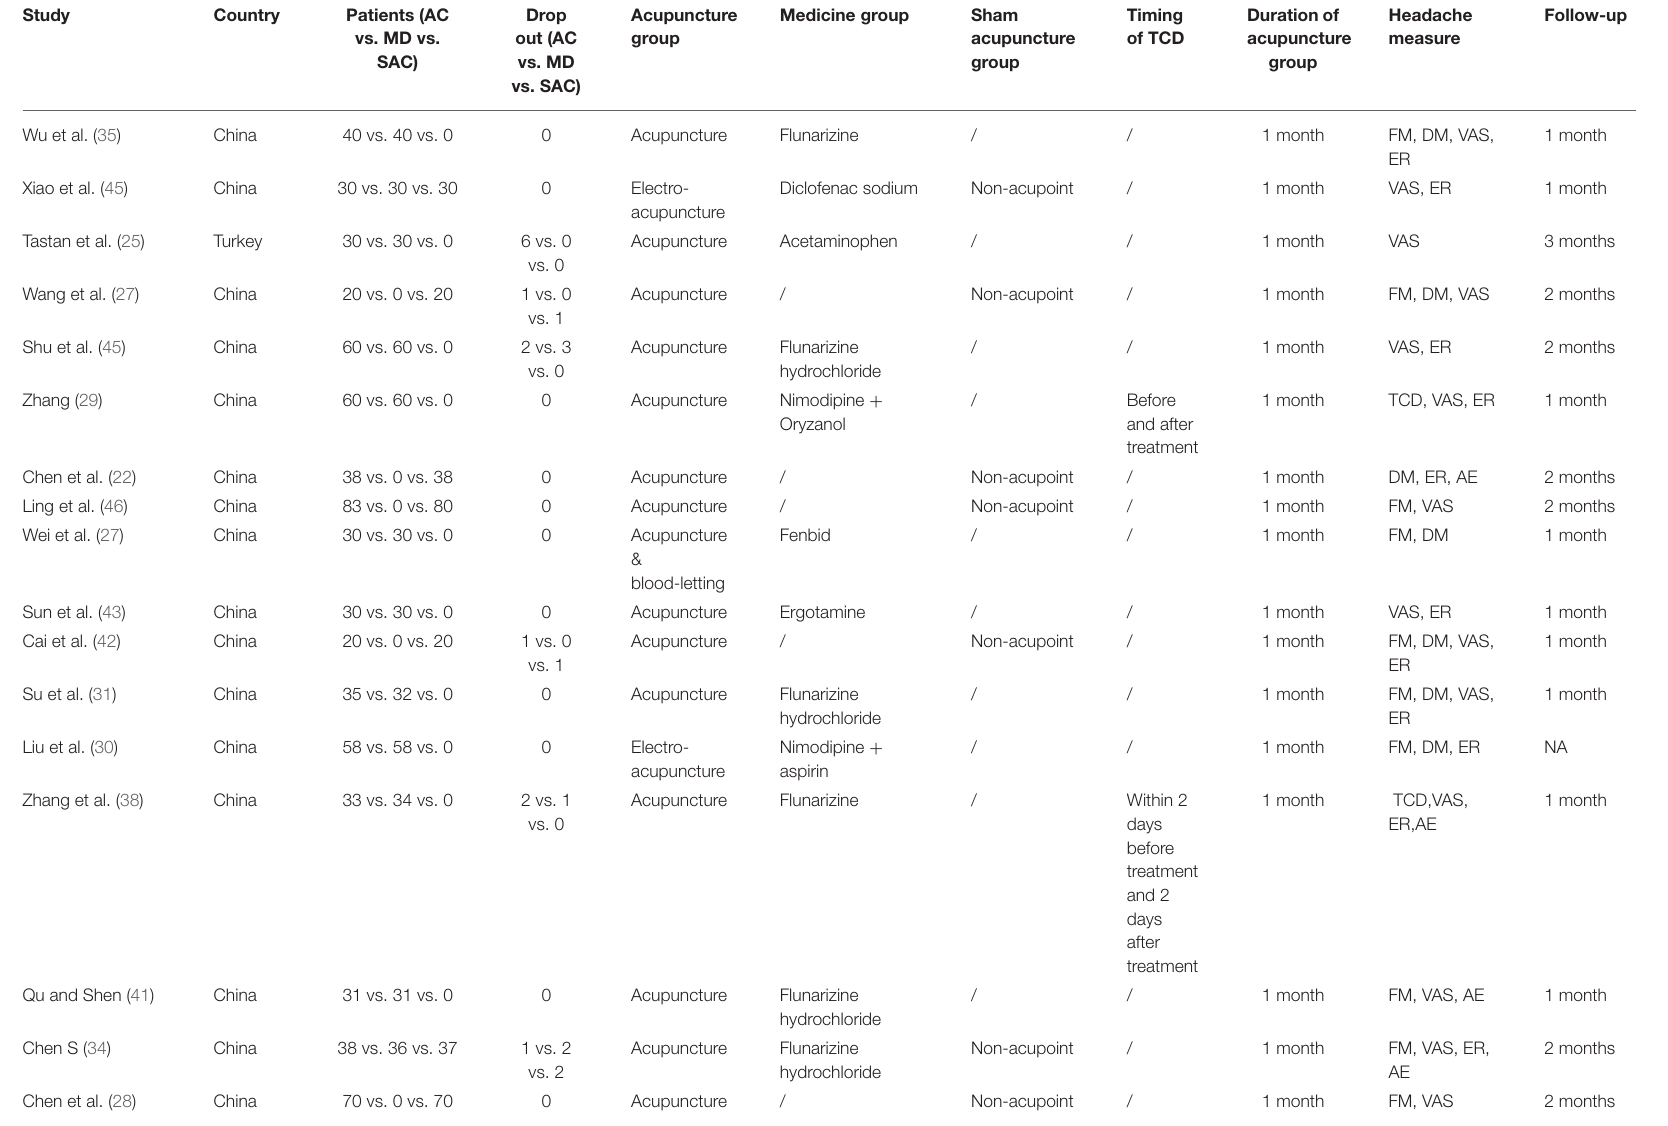
TABLE 1 | Characteristics of the included studies in the